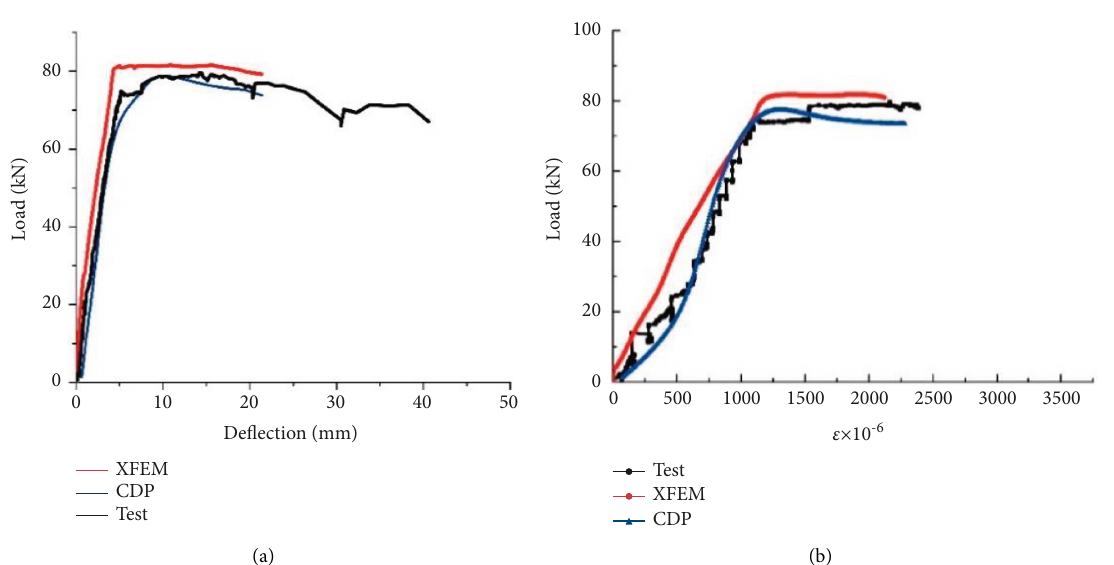
Figure 17: Comparison of curves among XFEM, CDP, and test. (a) Relation between deflection and load. (b) Relation between strain and